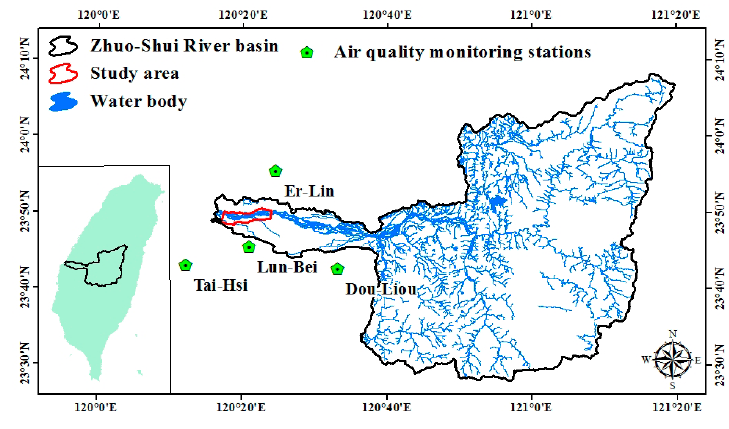
Figure 1. Cont. Figure 1.